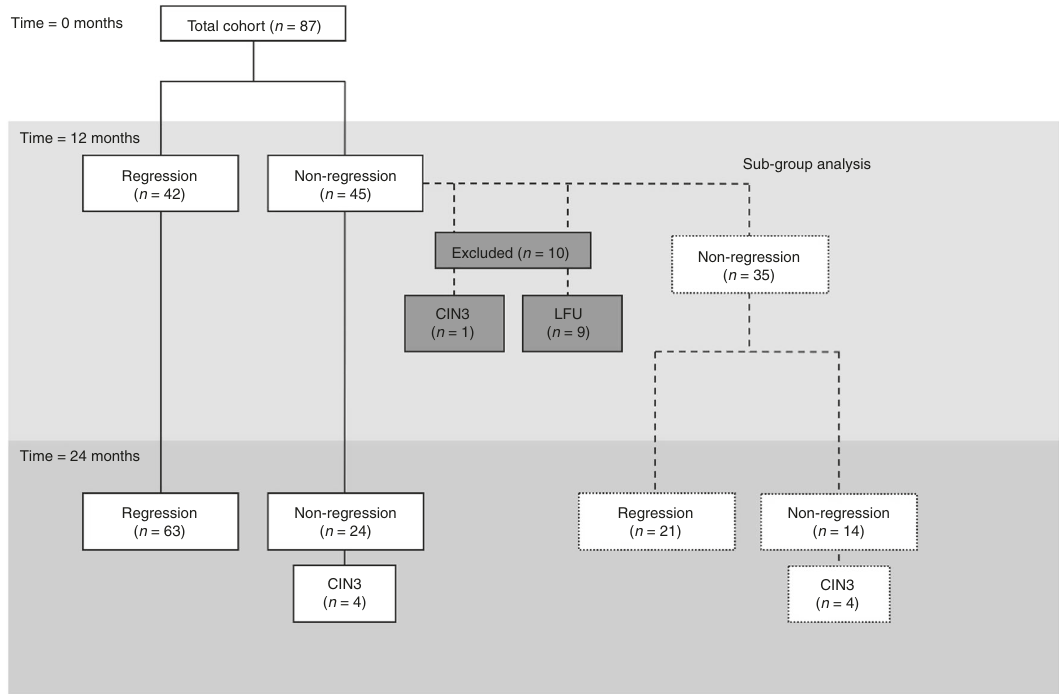
Fig. 1 Study cohort and timepoints. All patients entered the study at baseline with histologically con fi rmed CIN2. The results of follow-up histology and cytology were assessed at 12 and 24 months to determine whether the individual had regressed (at least 2× normal histology or cytology) or not (non- regression). By 12 months, 45 patients were classi fi ed as non-regressors. Of these, one patient had progressed to CIN3 and nine were subsequently lost to follow-up, leaving 35 patients for a further subgroup analysis. The vaginal microbiome composition at this 12-month follow-up visit was then regarded to be the ‘ new baseline ’ , and the outcome from 12 to 24 months was then assessed. LFU lost to